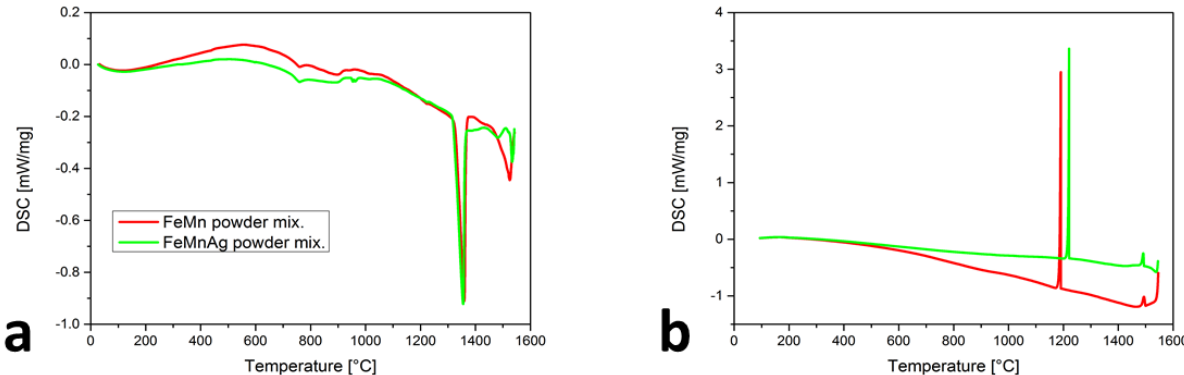
Figure 1. DSC results of Fe-M and Fe-Mn-Ag powder mixtures: ( a ) heating cycles, ( b ) cooling cycles.